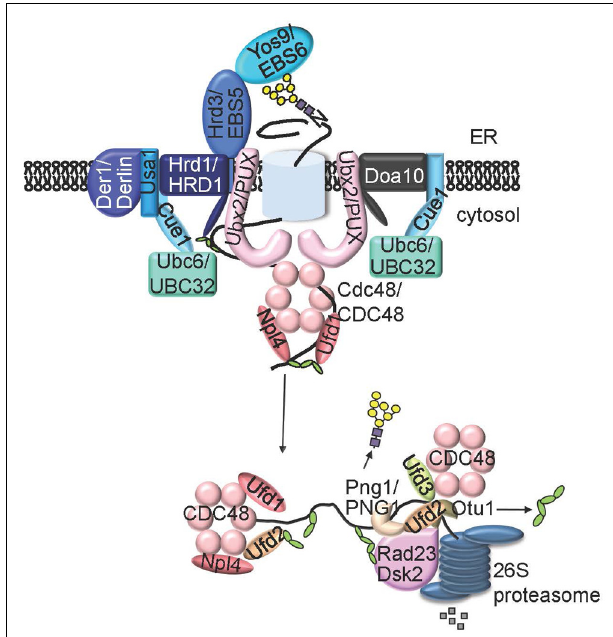
FIGURE 3 |A model of ERAD system. An ERAD client that has lesion in membrane-embedded segment (ERAD M ) or in ER lumen region (ERAD L ) is recruit by Hrd3 (EBS5 in Arabidopsis ) andYos9 (EBS6/OS9 in Arabidopsis ) to the membrane-anchored E3 ligase Hrd1 (AtHrd1A and AtHrd1B in Arabidopsis ) complex that also contains Cue1, Ubc6 (UBC32 in Arabidopsis ), Usa1 and Der1. An ERAD substrate with a folding lesion in the cytosolic domain (ERAD C ) is recruited to a different ER membrane-anchored E3 ligase complex that contains Doa10 and Ubc6 (or Cue1/Ubc7).The two E3 ligase complexes share similar components on the cytosolic side of the ER membrane, including the substrate-extracting Cdc48-Ufd1-Npl4 trimeric complex and its membrane recruitment factor Ubx2 (one or more AtPUX proteins in Arabidopsis ). An extracted polyubiquitinated ERAD substrate is processed by Ufd2, Ufd3, Otu1, and/or Png1 (AtPNG1 in Arabidopsis ), delivered to the cytosolic proteasome with help of Dsk2 and Rad23, and eventually proteolyzed by the 26S